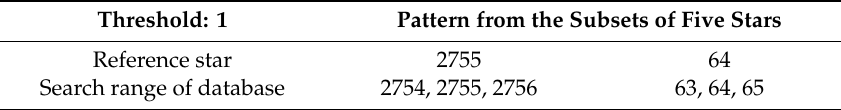
Table 2. Example of the initial matching in the case of threshold 1.